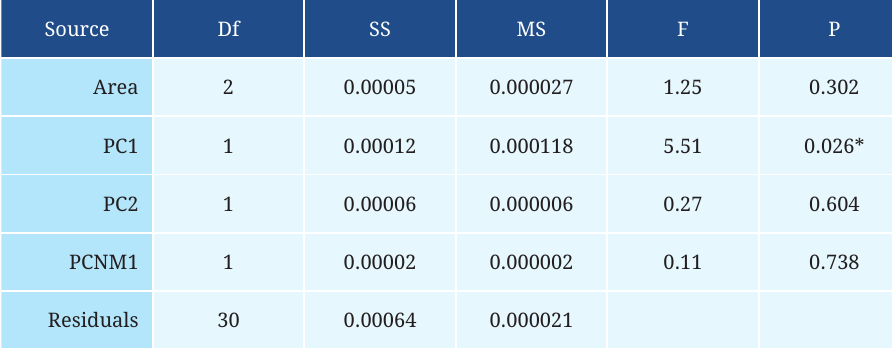
TABLE 4 | Fish species composition PERMANOVA table. Source: Area type (Area), environmental